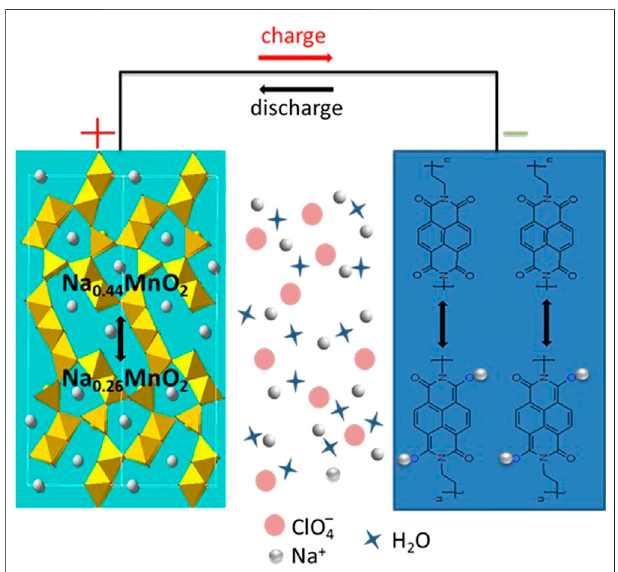
FIGURE 9 | A description of aqueous Na-ion battery with tunnel-type Na 0.44 MnO 2 cathode and PI anode.